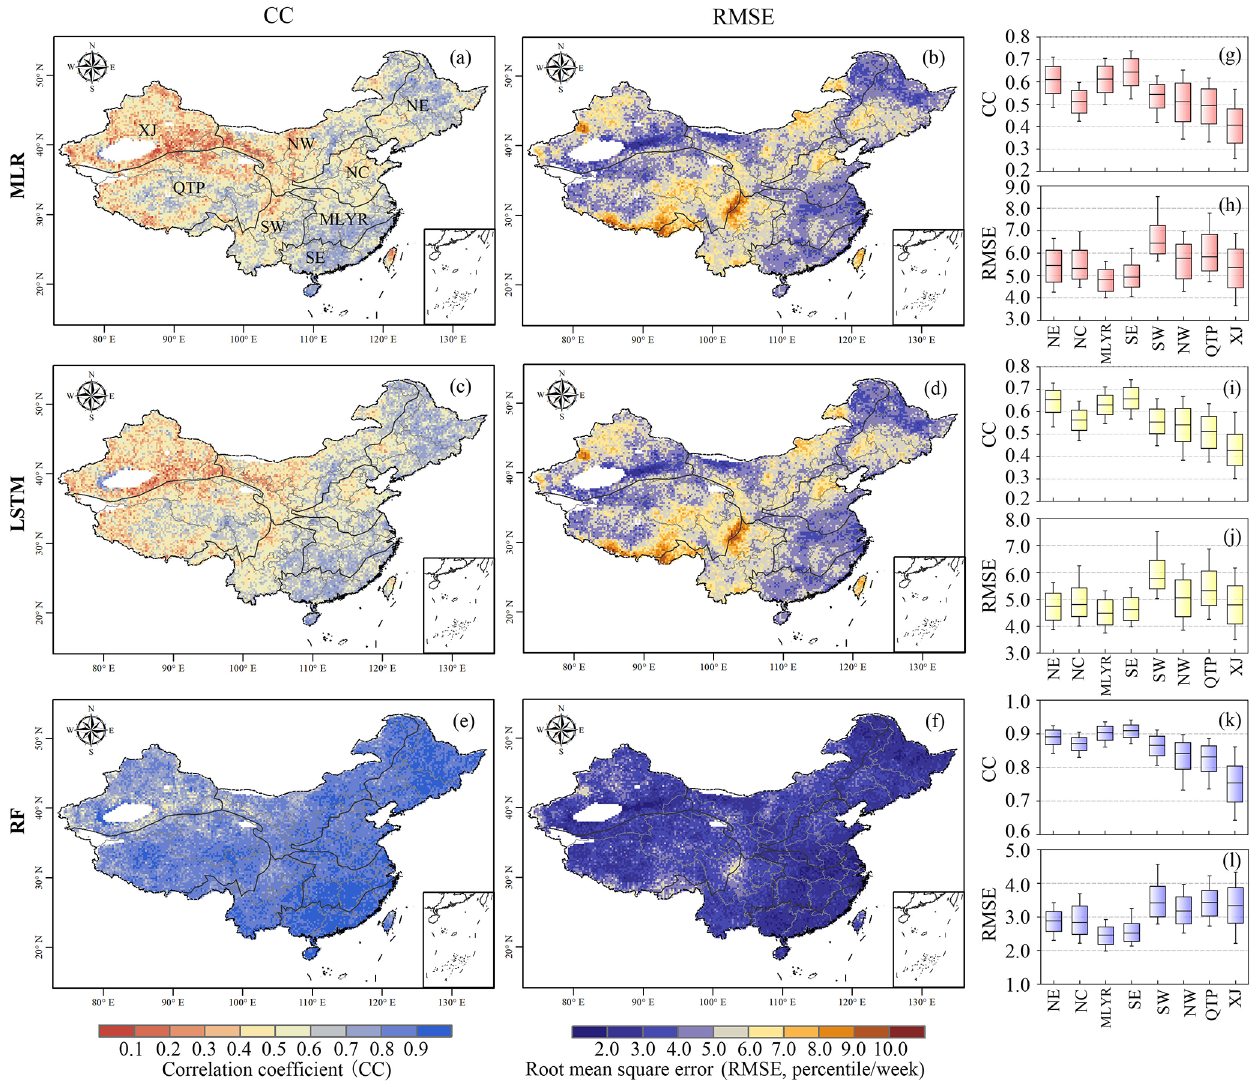
Figure 4. Spatial distribution of correlation coefficient (CC) and root mean square error (RMSE) of the estimated RI by (a–b) MLR, (c– d) LSTM, and (e–f) RF models against the observed RI. (g–l) Box plots of the CC and RMSE for eight sub-regions,